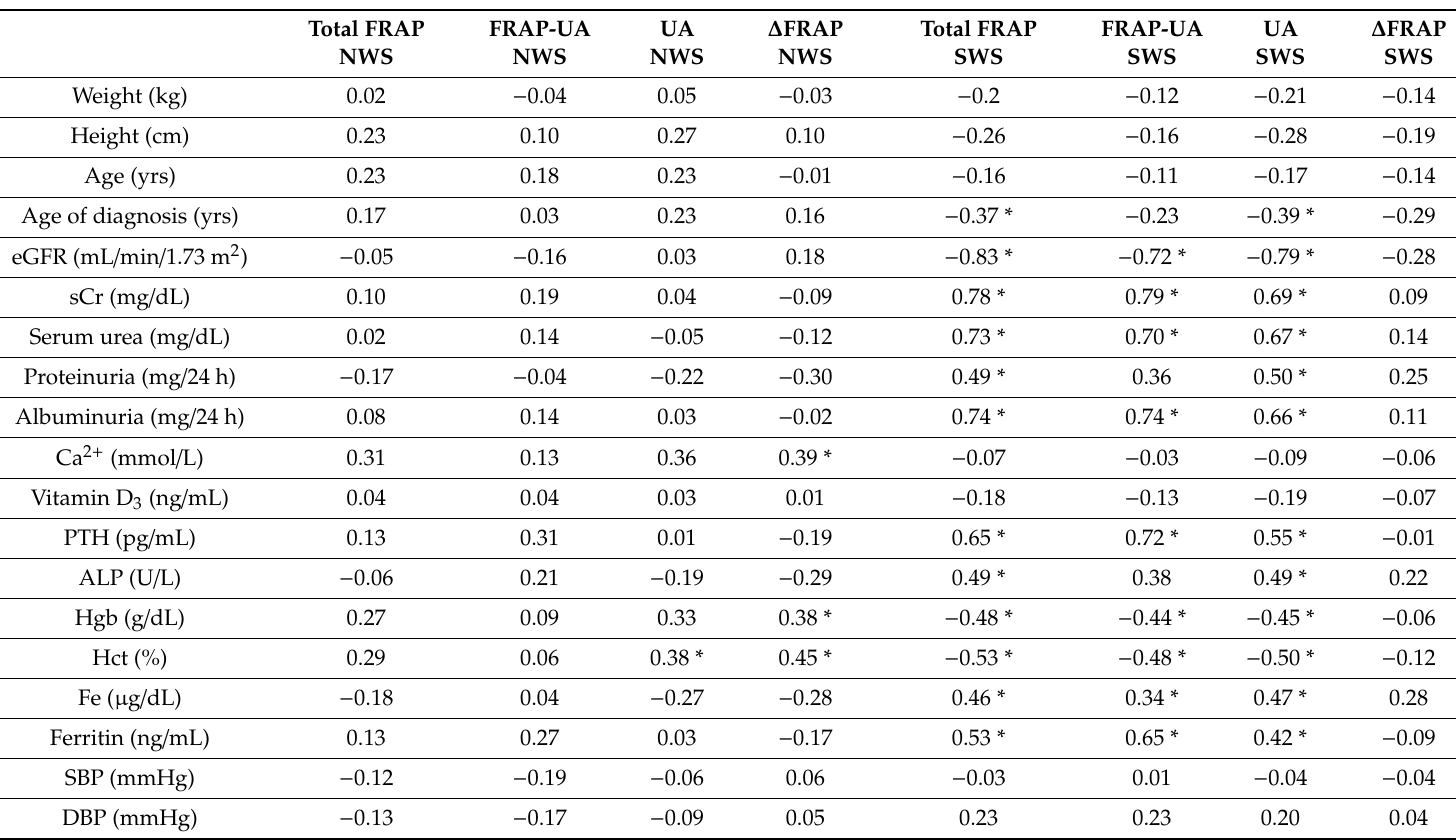
Table 6. Correlations between total antioxidant capacity measured by FRAP and clinical characteristics of children with chronic kidney disease